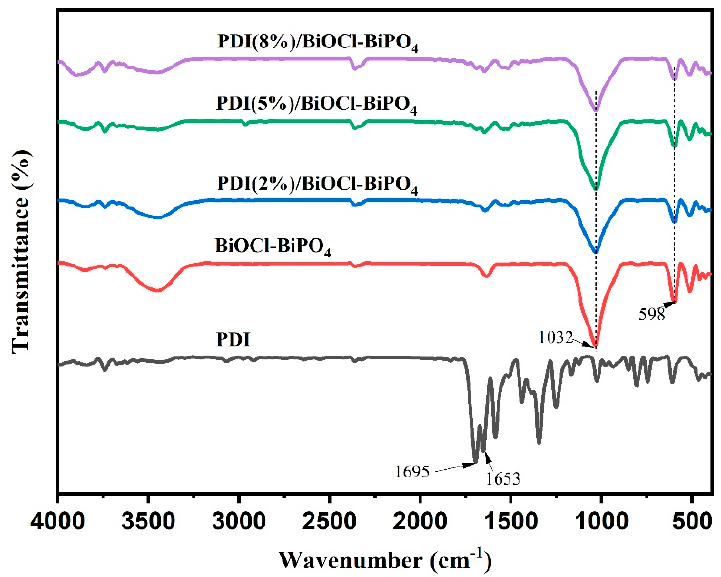
Figure 2. FT-IR spectra of PDI, BiOCl-BiPO 4 , PDI(2%)/BiOCl-BiPO 4 , PDI(5%)/BiOCl-BiPO 4 and PDI(8%)/BiOCl-BiPO 4 samples.